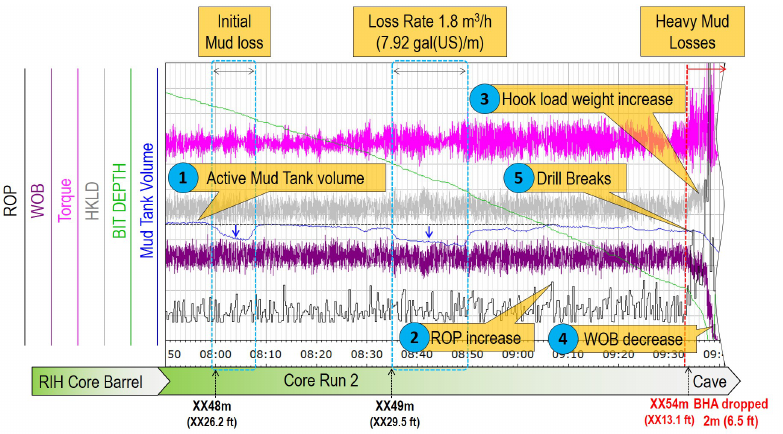
Figure 6. Drilling mechanics data in the interval close to cave (Well